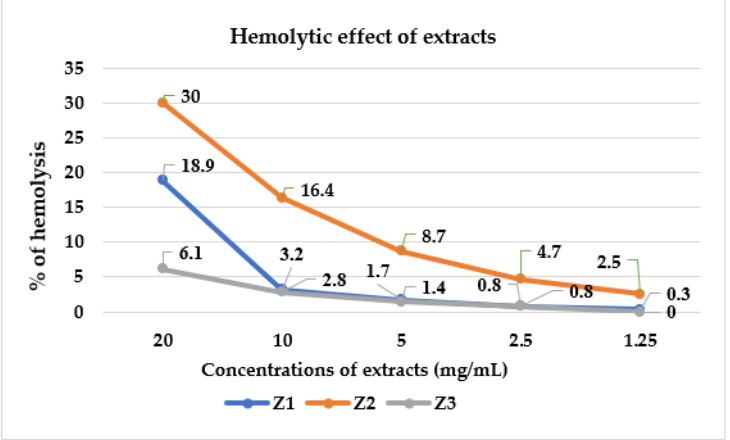
Figure 7. Hemolytic effect (% of hemolysis) of the studied extracts from Z. bungeana .